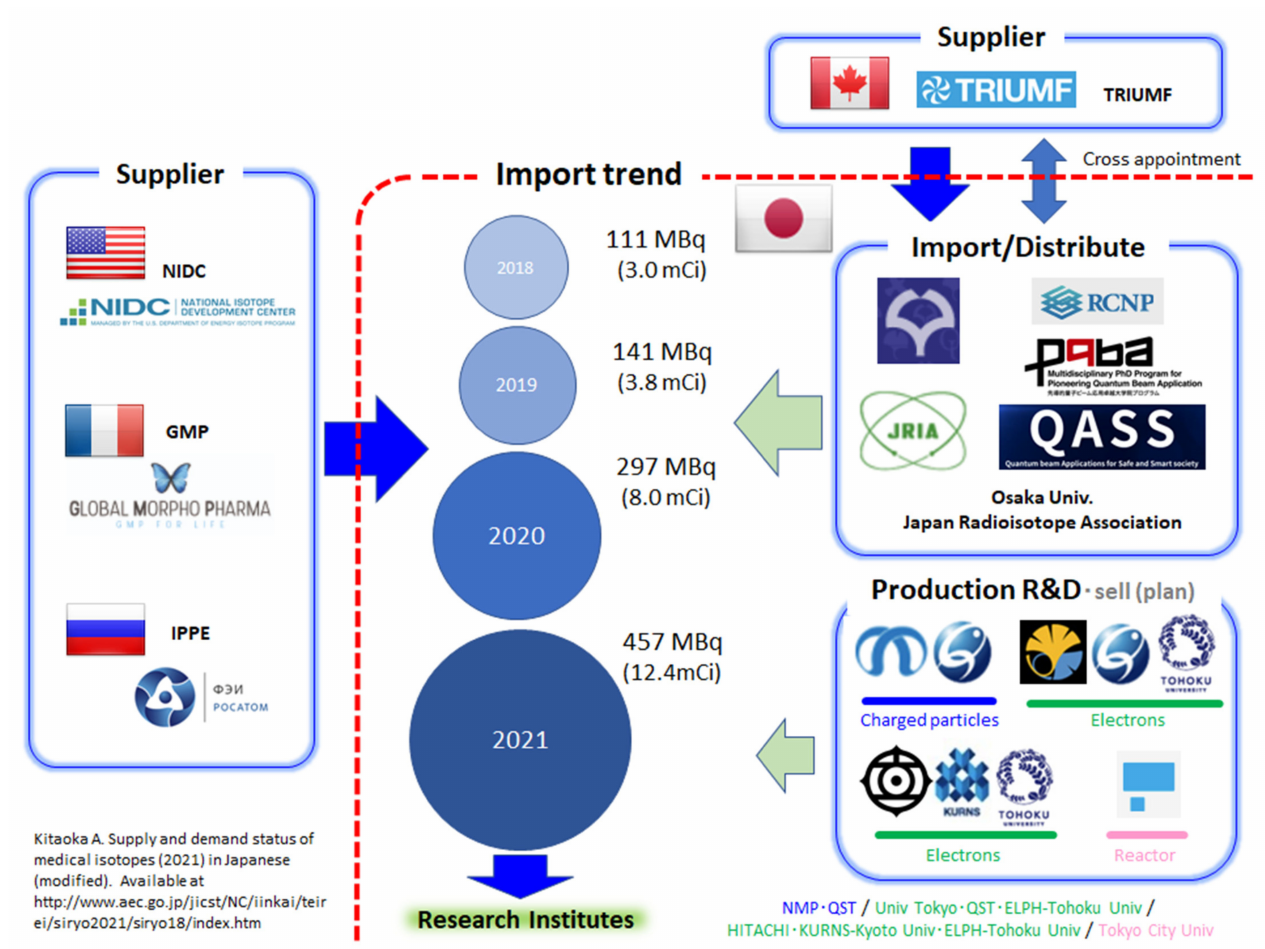
Figure 1. 225 Ac production, R and D, import, and distribution status in